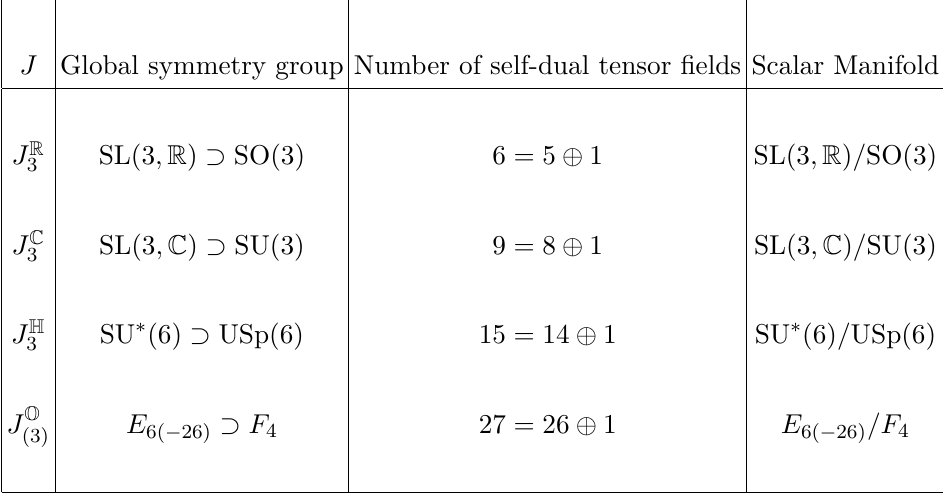
of degree three where 3